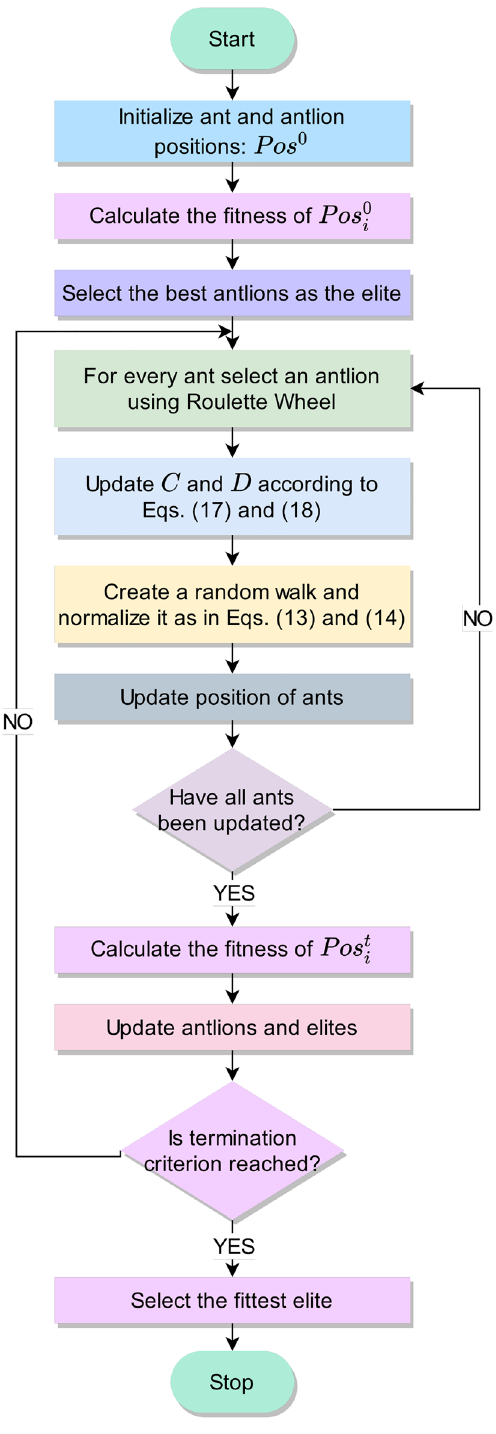
Figure 4. Flowchart of the ALO algorithm used in our proposed DSwarm-Net model.